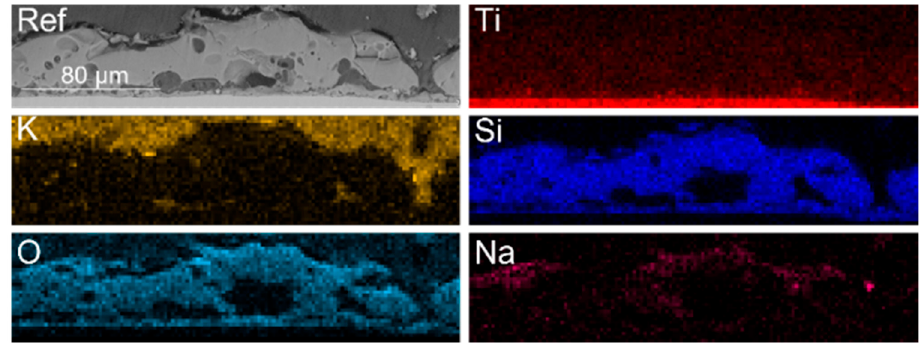
Figure 4. EDX mapping of the cross section of the reference sample.